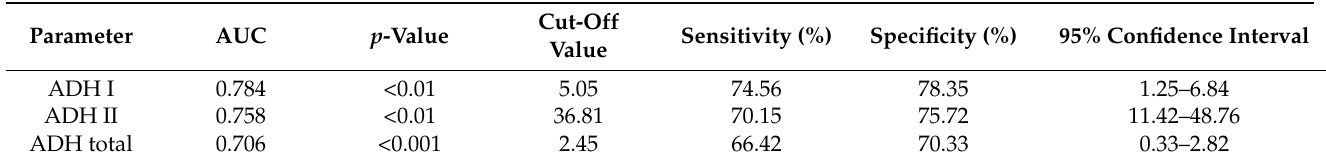
Table 3. Receiver operating characteristic (ROC) analysis of ADH I, ADH II, and ADH total of patients with alcoholic fatty liver and the